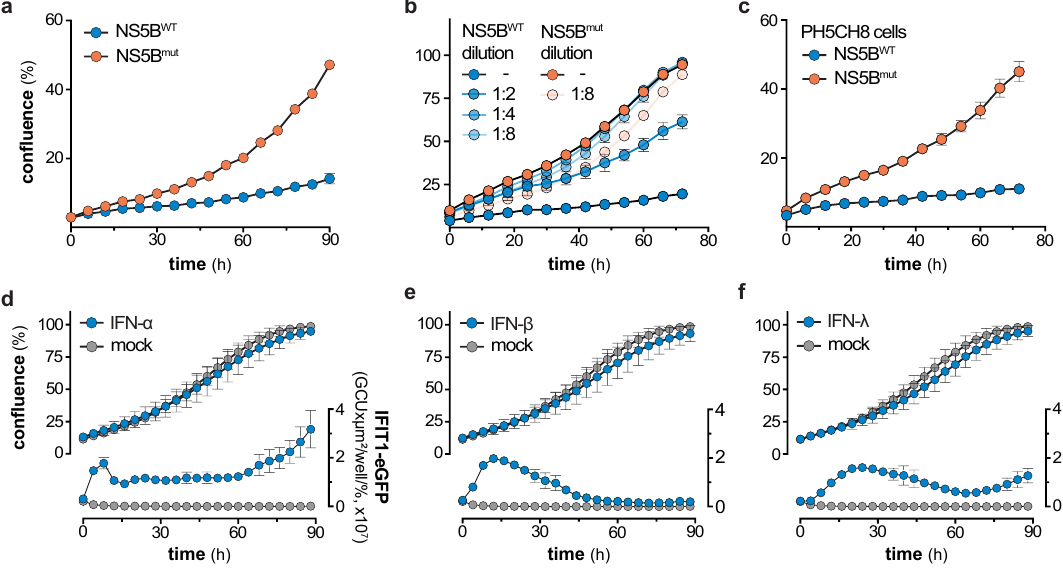
Figure 4. NS5B expression but not IFN treatment leads to reduced cell growth. ( a ) Cell growth of A549 cells 5 days after NS5B WT or NS5B mut transduction as determined by live cell imaging (mean ± s.d. of n = 5 technical replicates). One representative of n = 3 independent experiments is shown. ( b ) Cell growth of A549 cells 5 days after NS5B WT or NS5B mut transduction with increasing dilutions of NS5B expressing lentivirus (mean ± s.d. of n = 4 technical replicates). ( c ) Cell growth of PH5CH8 cells 5 days after NS5B WT or NS5B mut transduction as determined by live cell imaging (mean ± s.d. of n = 4 technical replicates). One representative of n = 3 independent experiments is shown. ( d , f ) Cell growth of A549-IFIT1-eGFP cells treated with 8.25 ng / mL IFN- α ( d ), 17 IU / mL IFN- β ( e ), or 9 ng / mL IFN- λ ( f ) for the indicated time (mean ± s.d. of n = 4 technical replicates and n = 3 independent experiments). Left y-axis shows the percentage confluence and the right y-axis the IFIT1-eGFP expression based on the confluence-normalized green integrated intensity per